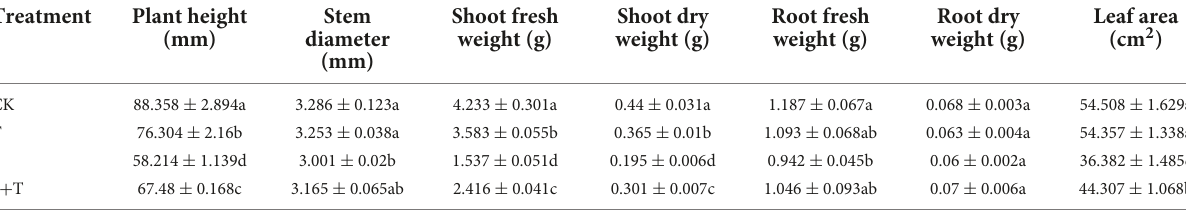
TABLE 1 Effects of Tre treatment on the growth parameters in tomato seedlings under salt stress for 5 days.